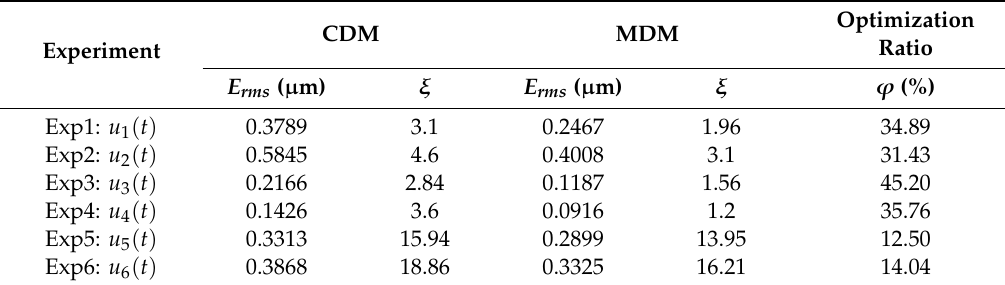
Table 3. The simulation errors of the CDM and